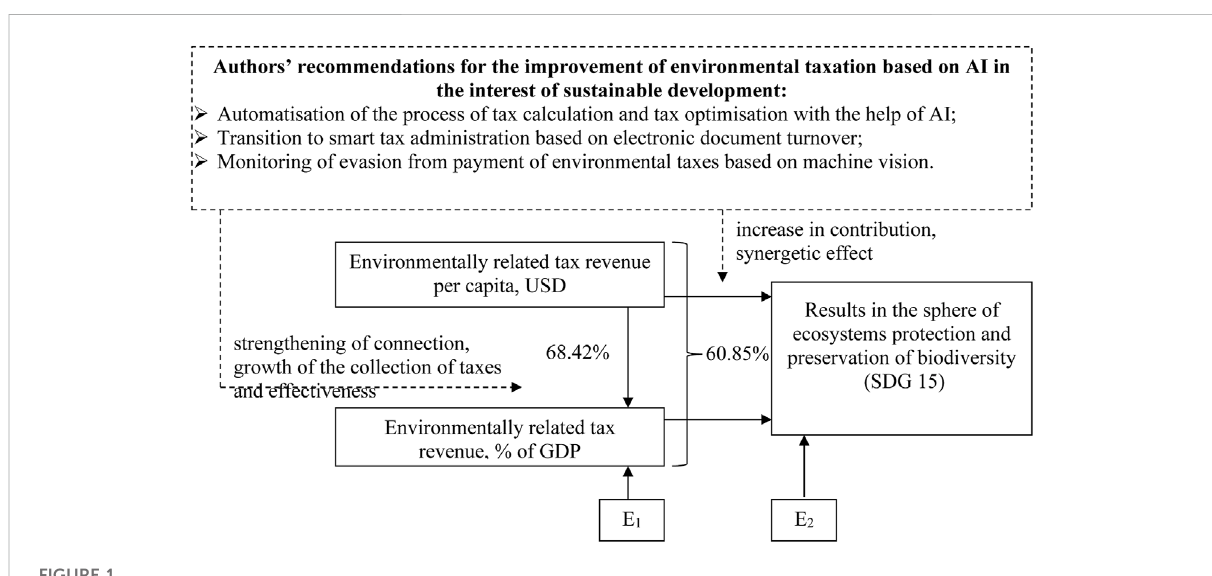
FIGURE 1 Framework model of the research, Source: